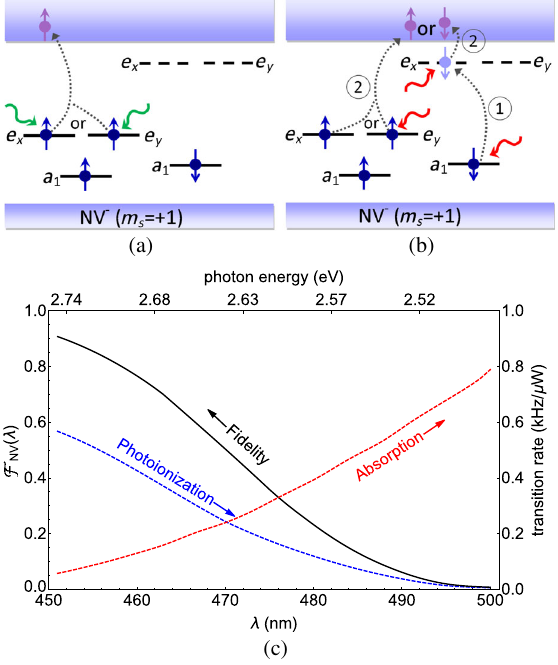
FIG. 5. The one- (a) and two-photon (b) ionization mechanisms of NV − . The depicted mechanisms correspond to photionization 1 spin state of the NV − ground 3 A from the m 2 level. In (a), s ¼ þ one photon with energy > 2 . 6 eV ejects an electron from the spin-up e spin orbitals of NV − into the conduction band. In (b), one photon with energy > 1 . 946 eV promotes an electron from the occupied spin-down a 1 spin orbital to one of the unoccupied spin-down e spin orbitals (i.e., a transition from 3 A 2 to 3 E ). A second photon with energy > 1 . 946 eV ejects an electron from either the spin-up e spin orbitals or the occupied spin-down e spin orbital into the conduction band. In (a) and (b), occupied or unoccupied spin orbitals are depicted as solid or dashed lines, filled circles represent electrons and solid arrows denote spin-up or spin-down electrons, wavelike arrows denote photons. Panel λ Þ (c) depicts the estimated ultimate photoionization fidelity F NV ð for one-photon photoionization (solid black line, left axis) [76] as well as the one-photon photoionization [42] (dashed blue line, right axis) and optical absorption [77] (dashed red line, right axis) transition rates per unit optical power (in the confocal arrange- ment described in Ref.